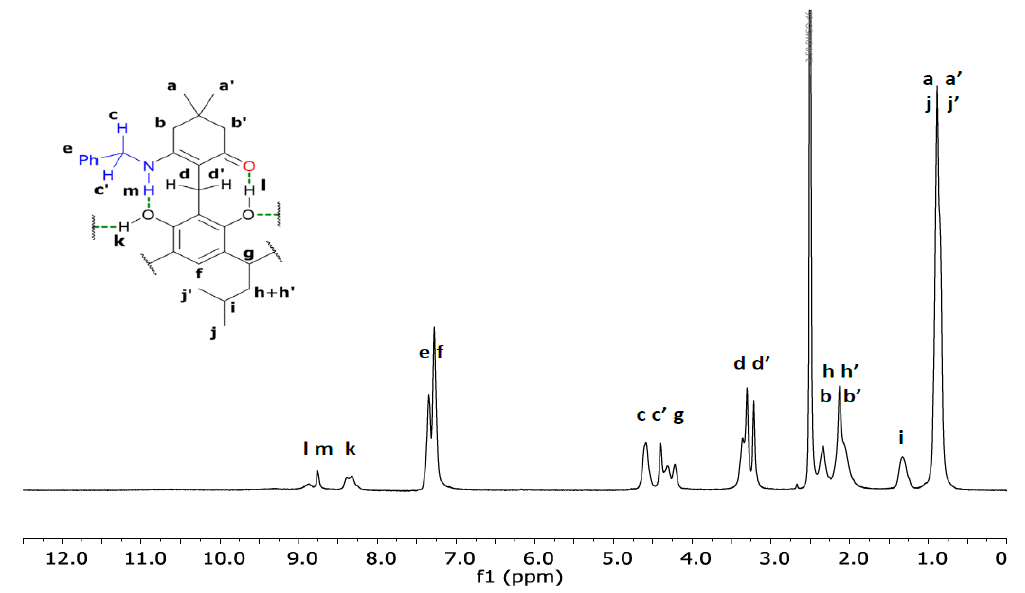
Figure 4. 1 H NMR spectrum of 4 in DMSO ‐ d 6 at 303 K.